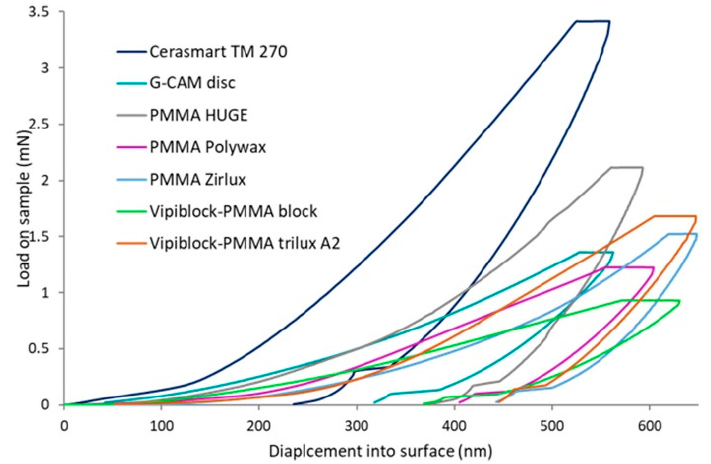
Figure 2. Graphical representation of load-displacement curves of all investigated CAD/CAM specimens subjected to nanoindentation.